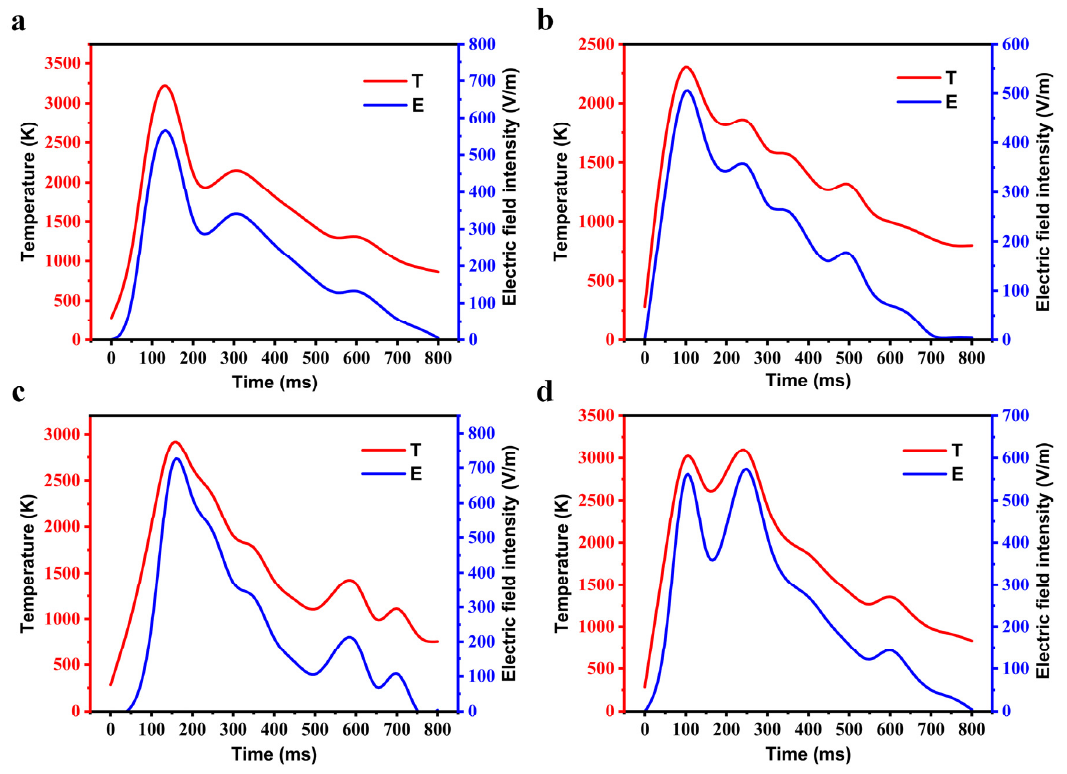
Figure 5. Variation diagram of temperature and electromagnetic intensity during detonation of energetic materials: ( a ) RDX; ( b ) TNT; ( c ) PETN; ( d )